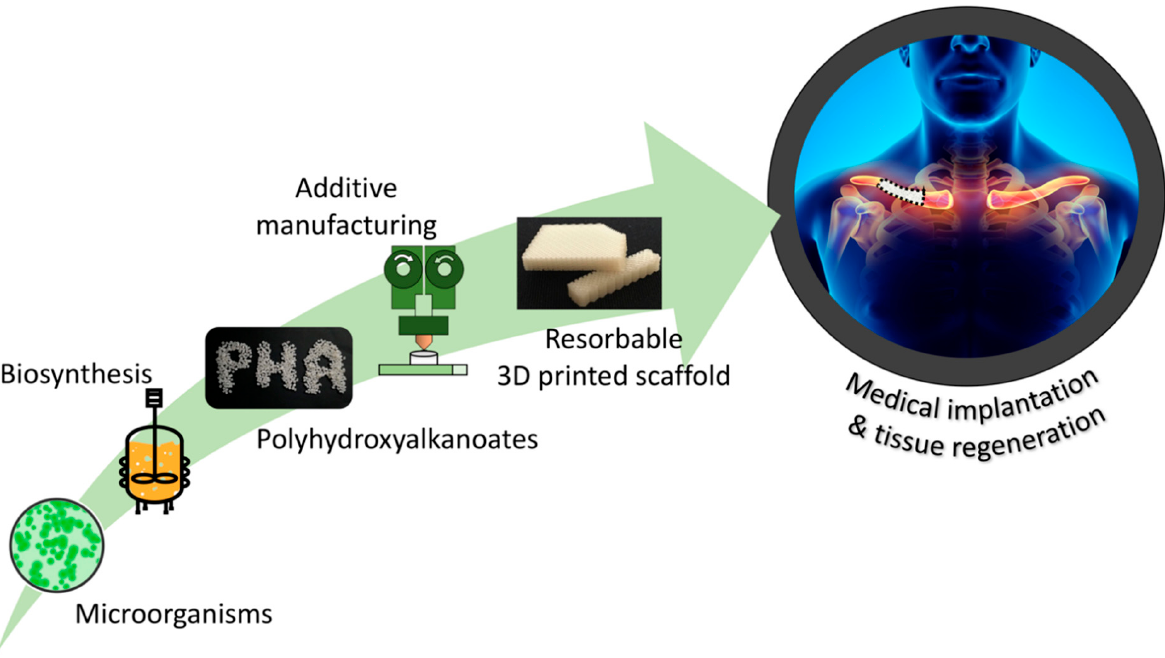
Figure 1. Schematic representation of the production, technological transformation, and biomedical applications of polyhydroxyalkanoate (PHA)-based devices.